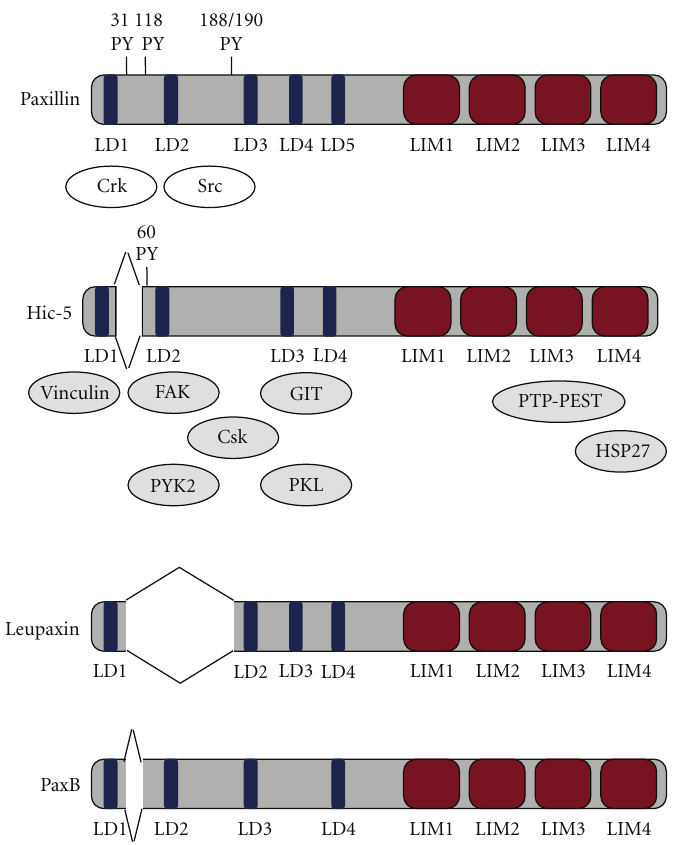
Figure 1: The paxillin/focal adhesion-associated adaptor protein family; domain structure and binding factors. The paxillin family includes HIC-5, Leupaxin, which is preferentially expressed in hematopoietic cells, and PaxB, an orthologue of paxillin in the slime mould Dictyostellium discoidium . The family members share many of their structural characteristics and binding factors. They have four to five leucine-rich motifs (LD repeats) in the N-terminal half and four cysteine-rich regions composed of two zinc fingers (LIM domains) in the C-terminal half. These domains mediate the protein-protein interactions that allow paxillin to bind a variety of structural and signalling molecules, such as the structural protein vinculin, the SH2-SH3 adaptor protein Crk, Src, focal adhesion kinase (FAK), PTK2B protein tyrosine kinase 2 beta (PYK2), a negative regulator of Src, the Csk nonreceptor tyrosine kinase, the G protein-coupled receptor kinase interactor Arf GAP1 (GIT-1), paxillin-kinase linker (PKL), protein tyrosine phosphatase-PEST (PTP-PEST), and heat shock protein 27 (HSP27). The LIM domains also mediate the localization of Hic-5 at the nucleus and at focal adhesions. HIC-5 has the same binding partners, except for Crk and Src, as